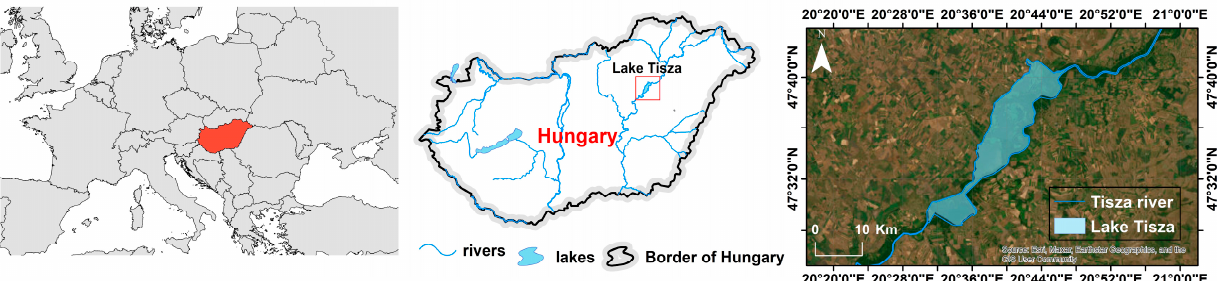
Figure 1. Location of the Kisköre Reservoir (Lake Tisza).